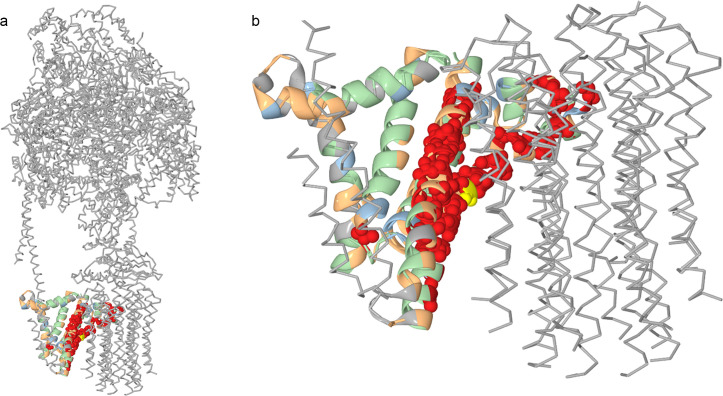
Groups of concordantly evolving sites and function of ATP6 in ATP synthase.For the mitochondrial-encoded ATP6 protein, the groups of coevolving sites are color-coded. Residues at sites of group 3 are shown as spheres; residues at other sites, as ribbons. Most residues at group 3 sites face the rotor part of the ATP synthase and may contribute to proton transport across the membrane. Yellow, Arg159 which also belongs to group 3.